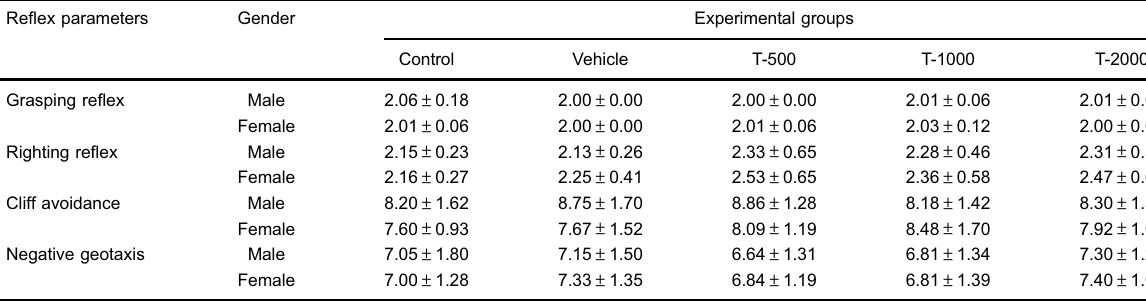
Table 3. Day of appearance of the neuromotor development signs analyzed in the groups. Re fl ex